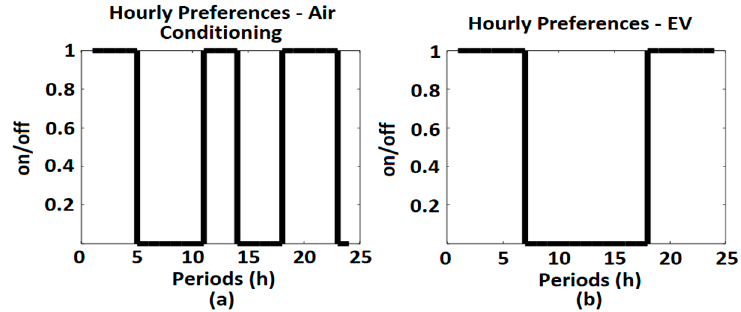
Figure 2. Hourly preferences related to air conditioning and the EV.